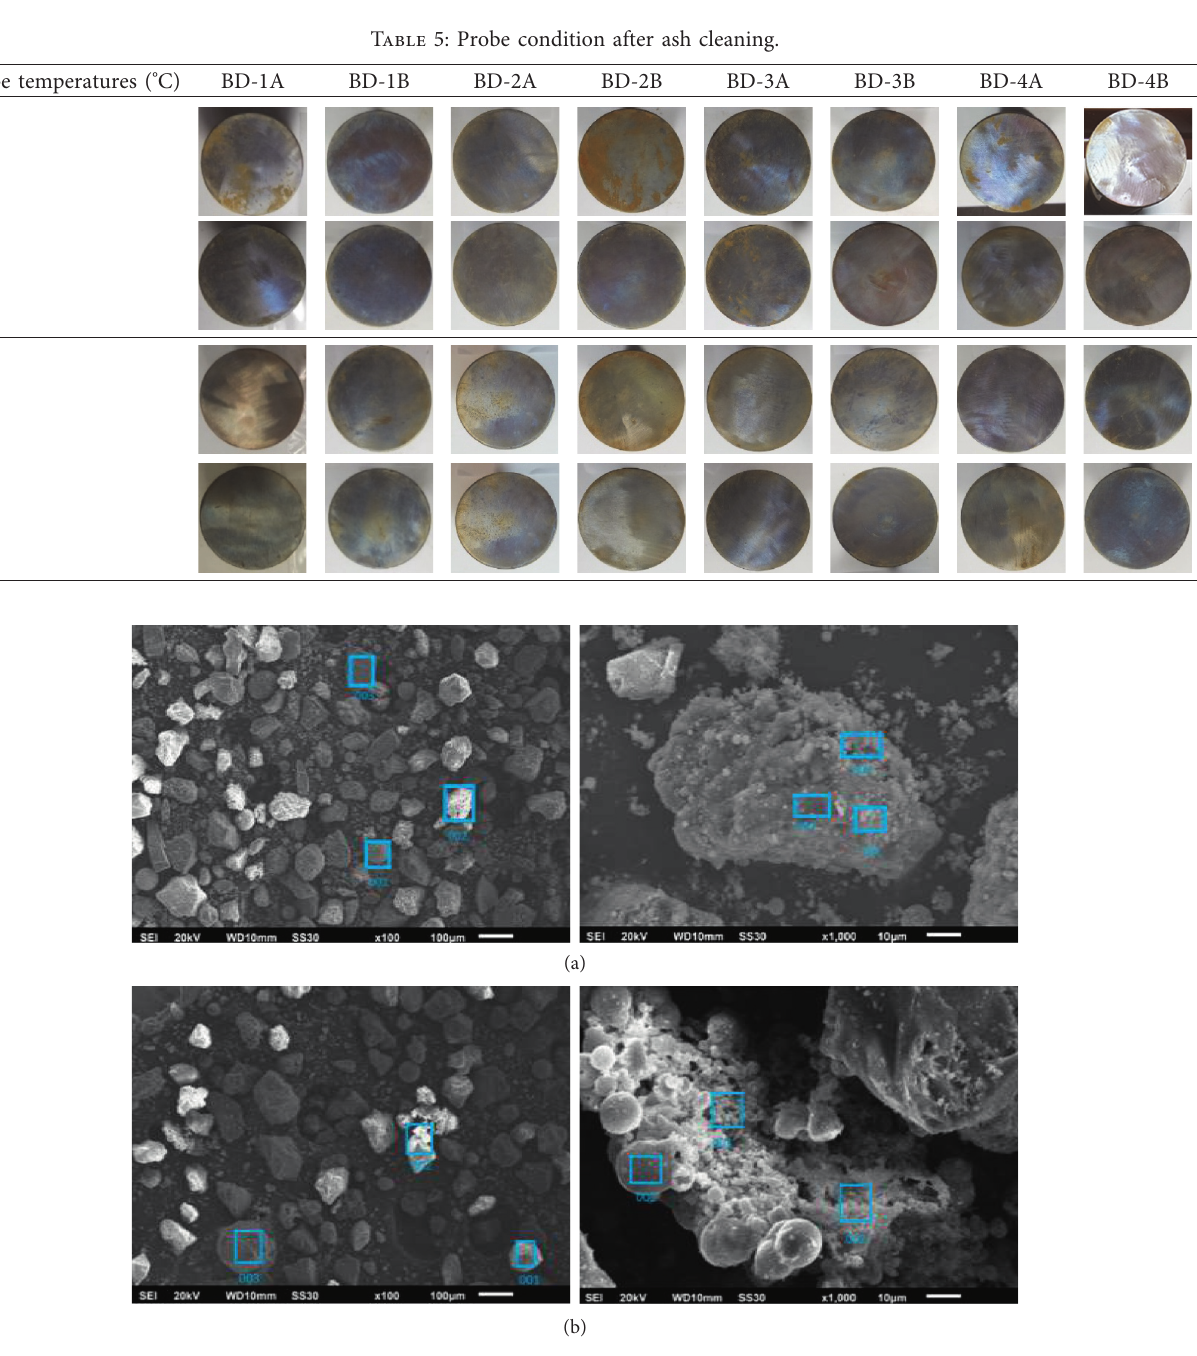
Figure 2: Comparison of 100x and 1,000x of BD-1A magnification at (a) 500 ° C and (b) 600 °